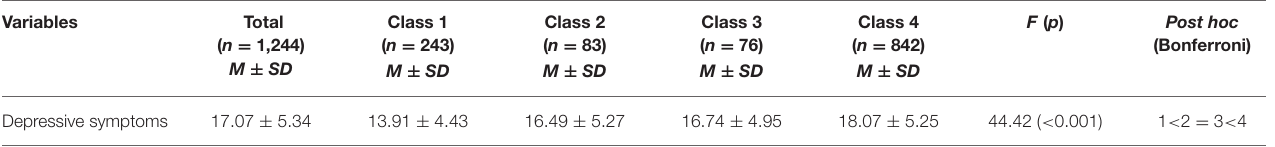
TABLE 4 | Comparison of depressive symptoms between the four classes ( N = 1,244). Variables